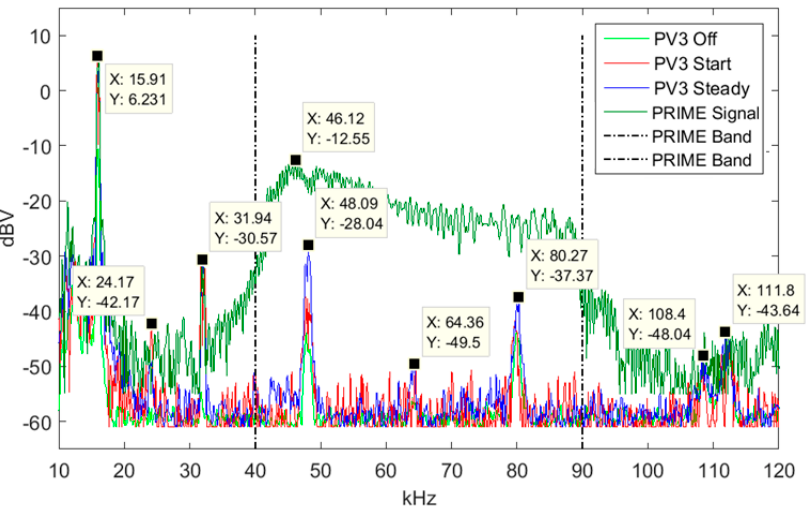
Figure 24. Spectrum recorded at PV3 inverter SM with the rest of inverters switched on and the battery charger disconnected.